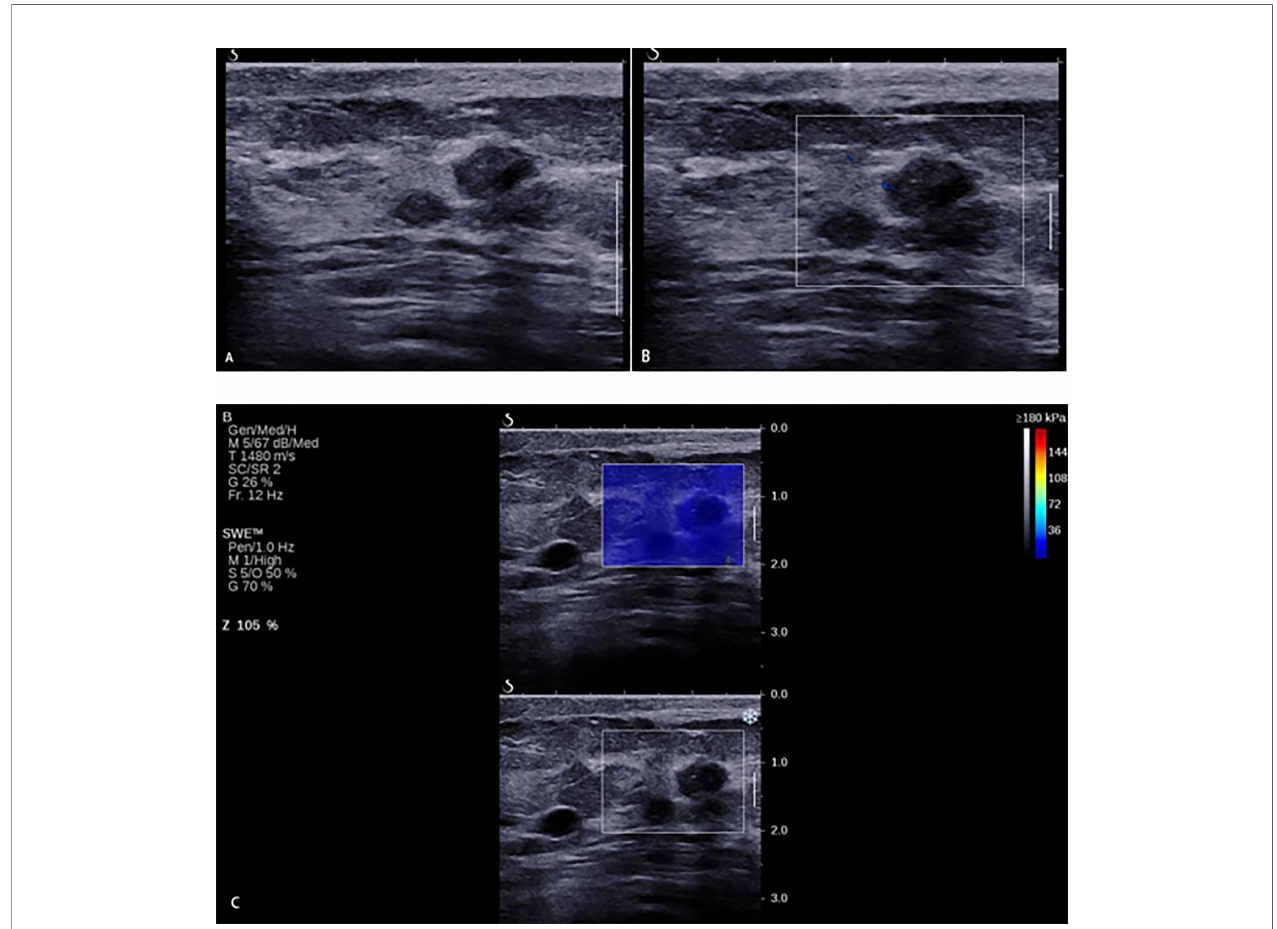
FIGURE 6 | A 33-year-old woman with breast lesions. (A) The conventional B-mode ultrasound revealed an 8 × 7-mm round, hypoechoic lesion with unclear margin in the right breast, which was categorized as Breast Imaging Reporting and Data System (BI-RADS) 4a. (B) The morphologic and distribution features of the microvessels in AngioPLUS microvascular Doppler ultrasound technique followed a linear pattern. (C) The qualitative shear wave elastography (SWE) feature showed no fi nding. Considering the benign manifestation both in AP and qualitative SWE, the fi nal category was downgraded into BI-RADS 3. The ultrasound-guided biopsy revealed the lesion as intermediate-grade intraductal